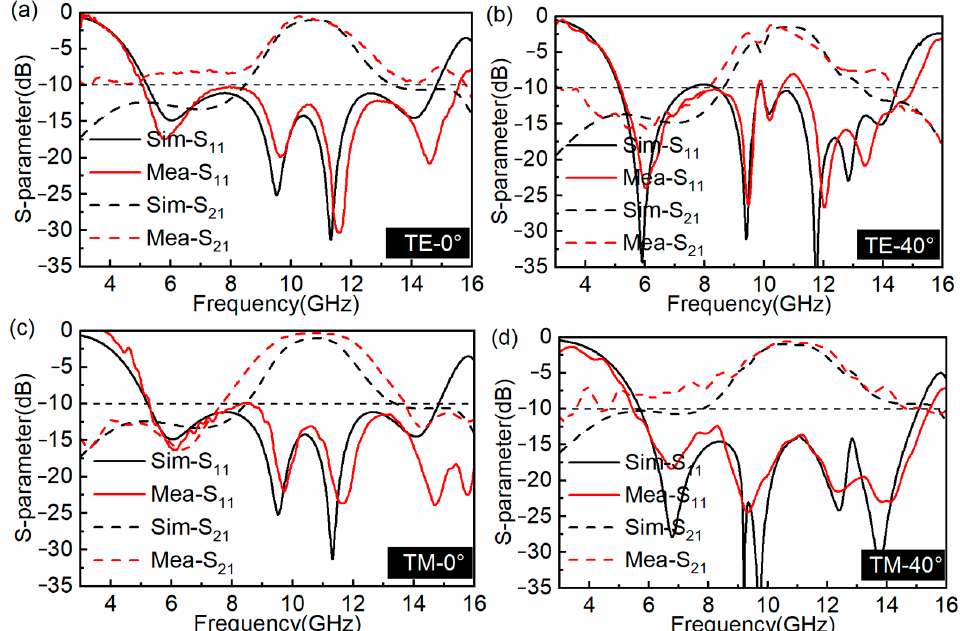
Figure 9. Fabricated sample and experimental system. ( a ) Lossy layer. ( b ) Bandpass layer. ( c ) Exper- imental system.